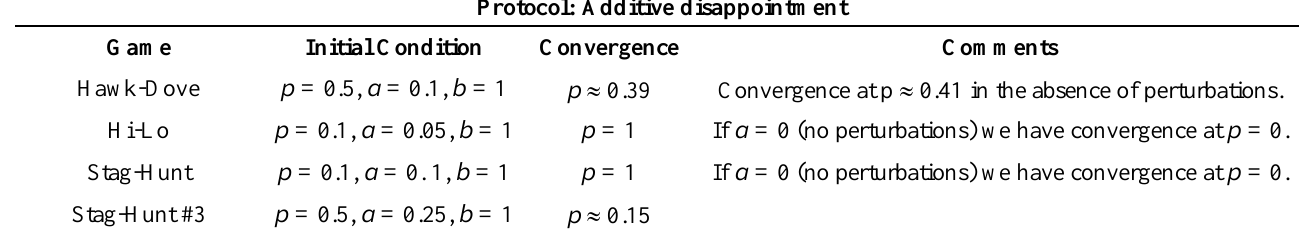
Table 6. Simulation results for additive disappointment protocol with stochastic